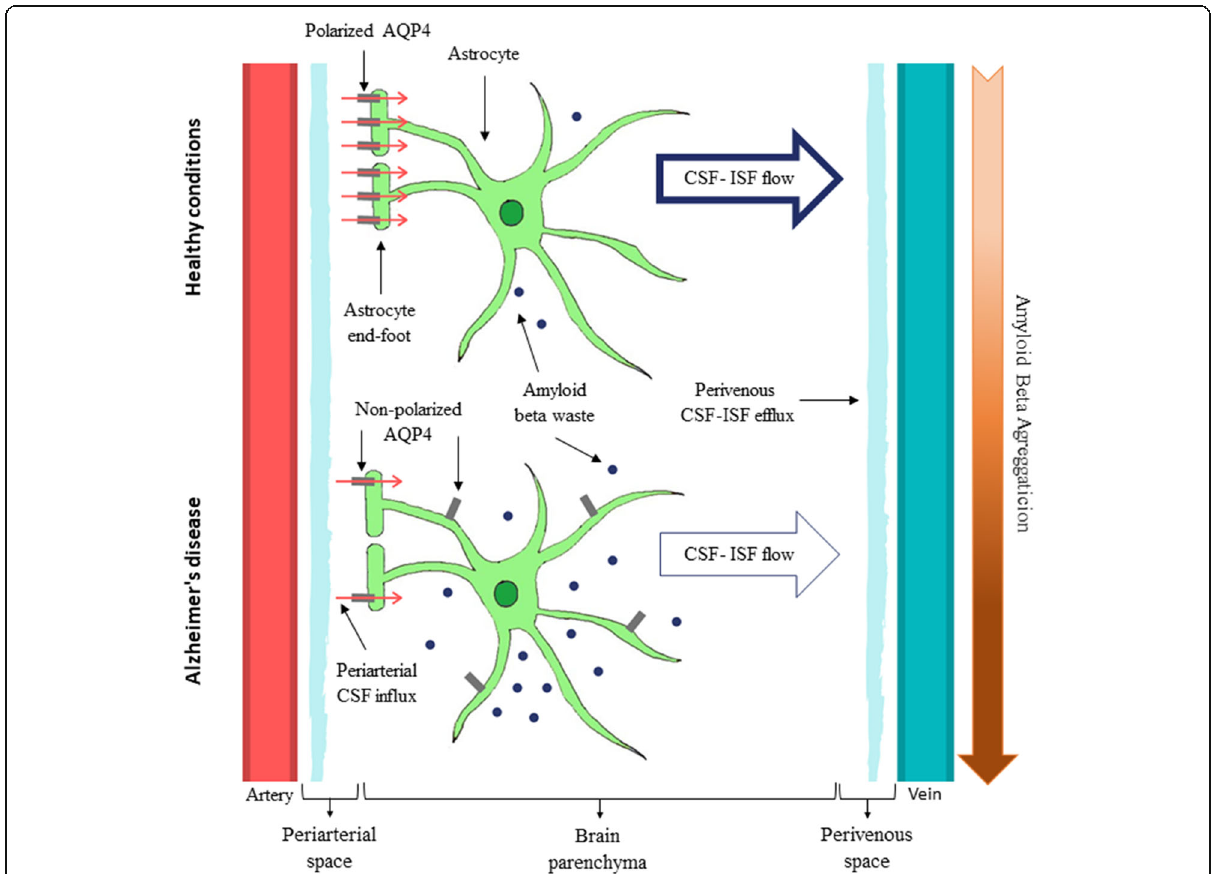
Fig. 2 Glymphatic System in Healthy vs AD condition. In healthy condition, CSF flows across highly polarized AQP4 molecules at astrocyte end- feet, mixing with ISF, which allows the clearance of A β . However, in pathological situations, such as in AD, there is a loss of AQP4 polarization, resulting in restricted CSF-ISF flow, contributing to A β